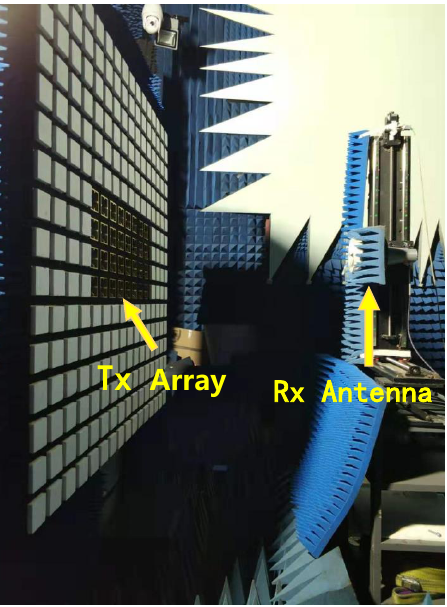
Figure 5. The side view of the experimental system with a measurement distance of 1